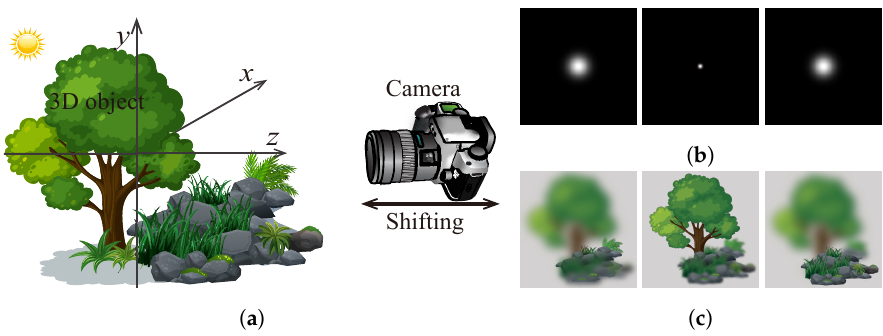
Figure 7. Scheme of focal sweeping capture ( a ); and a sample of the captured images of a point source ( b ) and a 3D scene ( c